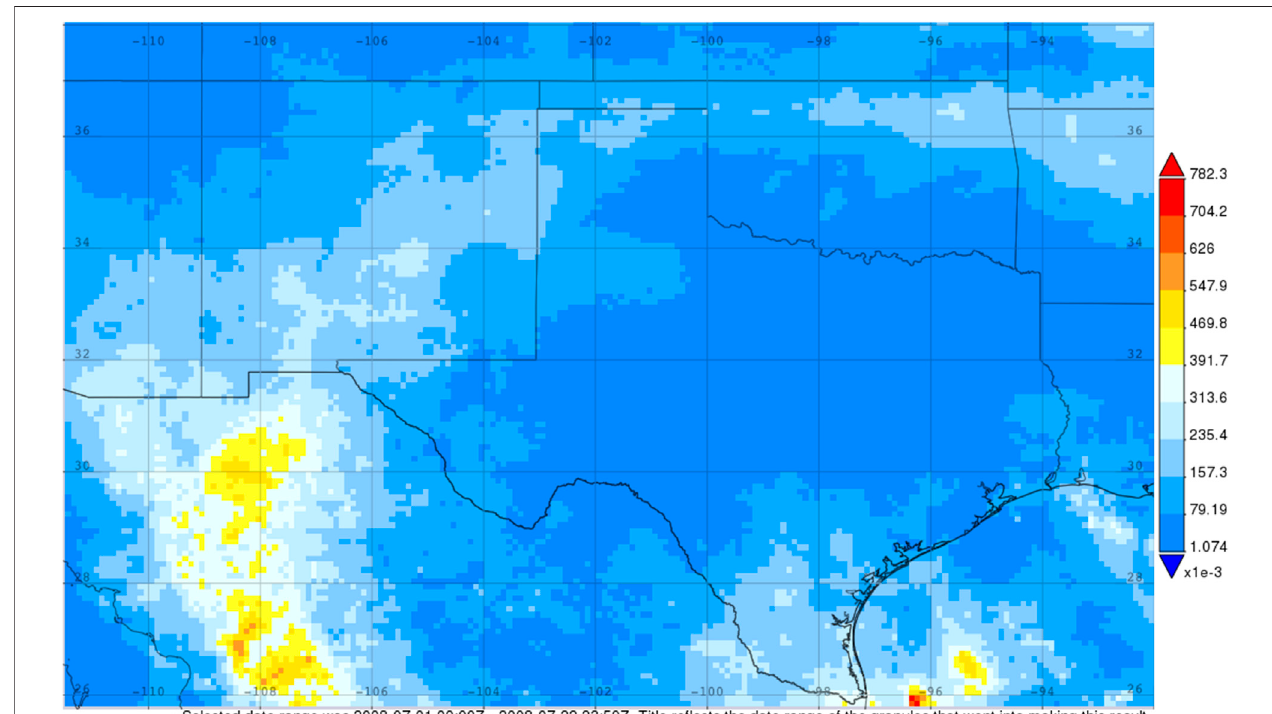
FIGURE 9 | Time-averaged map of the fi nal run of multi-satellite precipitation estimate with gauge calibration prior to the landfall of Hurricane Dolly (2008). Source: NASA Giovanni (Berrick et al., 2009; Acker and Leptoukh, 2007).